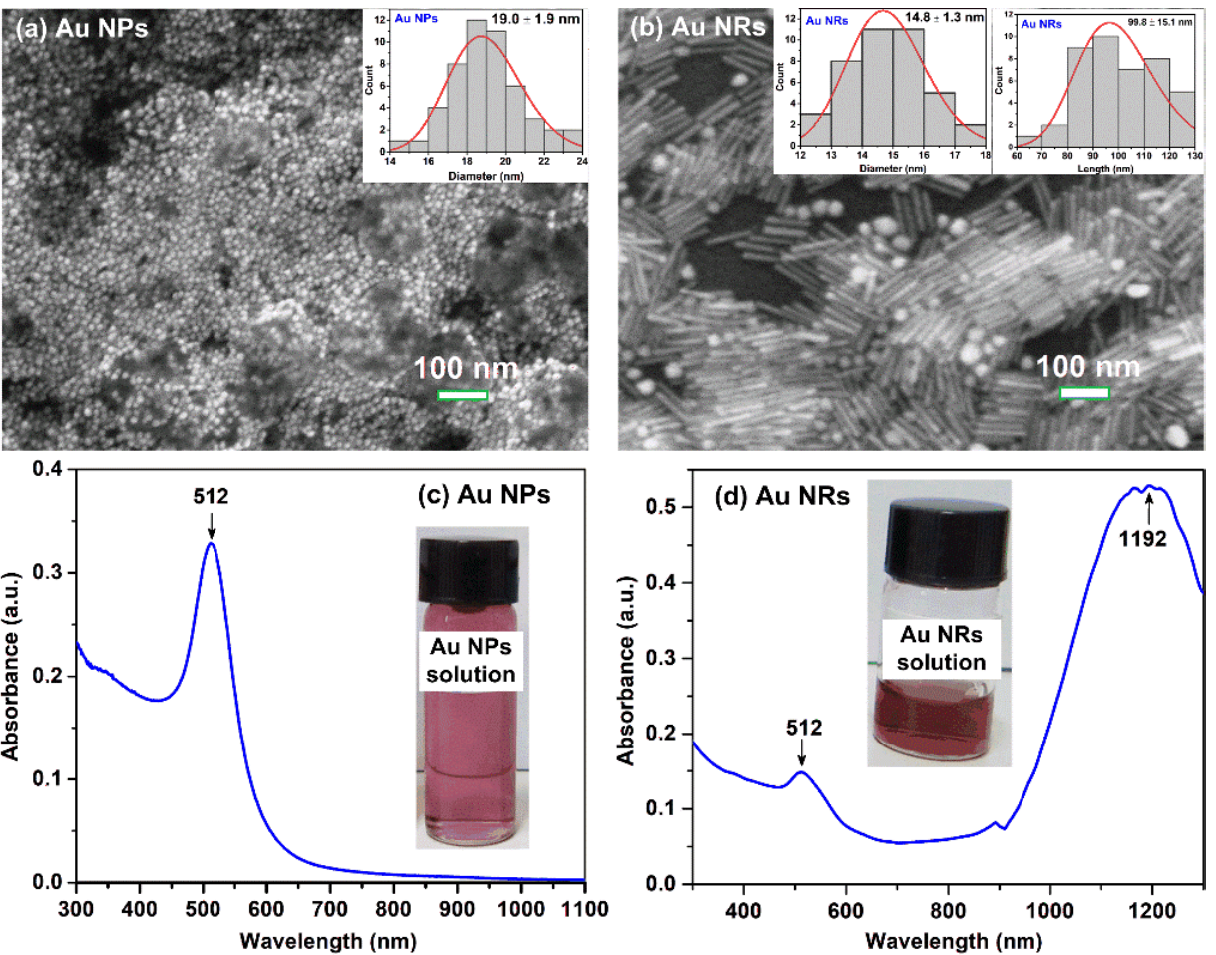
Figure 3. ( a , b ) SEM images of as-prepared Au nanoparticles and Au nanorods colloidal solutions. The insets in ( a , b ) are the size distribution histograms of Au NPs and Au NRs. ( c , d ) Absorption spectra of Au nanoparticles and Au nanorods solutions, showing a localized surface plasmon resonance (LSPR) peak at 512 nm for Au NPs, and two peaks at 512 nm and 1192 nm for Au NRs; the insets in ( c , d ) are the corresponding photographs of the Au NPs and Au NRs solutions.